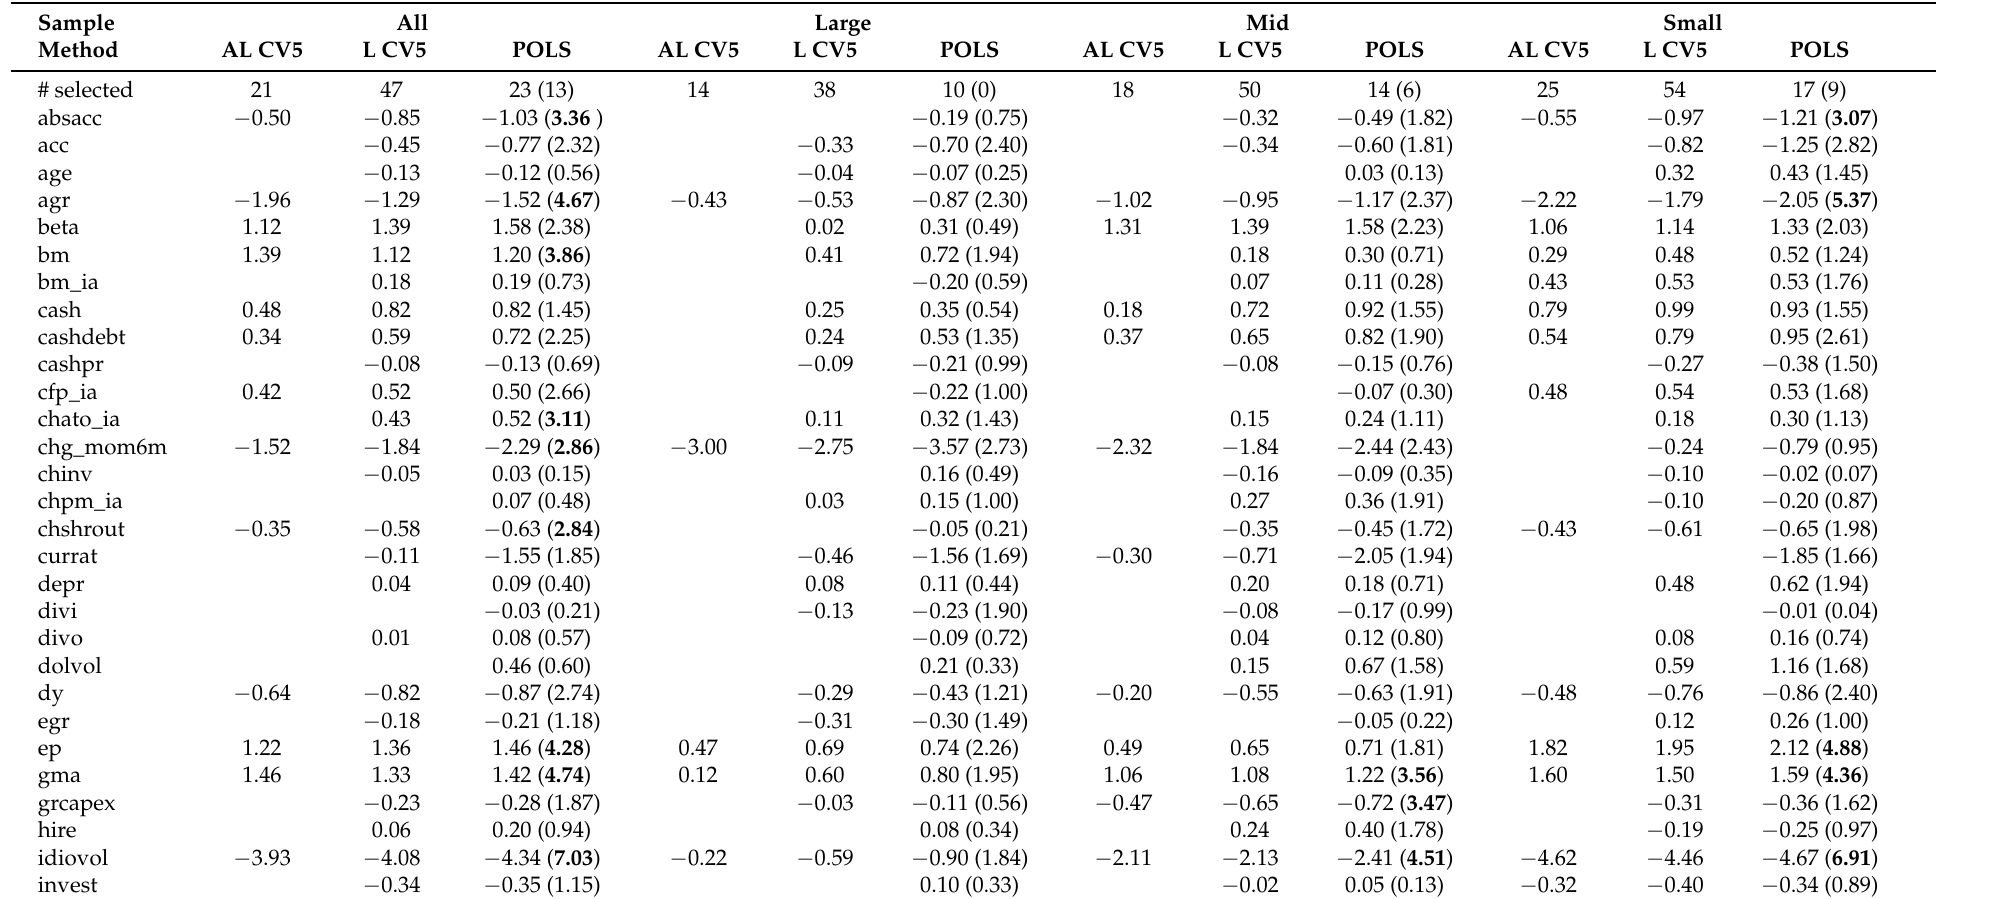
Table 3. Main pooled FC regression r = X (cid:48) γ + (cid:101) : The table exhibits the regression coefficients of POLS, Lasso (L) and adaptive Lasso (AL). POLS t-values are displayed in brackets, bold t-values indicate significance after a DFDR adjustment at the 5%-level. In case of POLS, row “# selected” counts FC with p -values ≤ 5%, the count for the DFDR equivalent is displayed in brackets. The other columns reflect the count of all non-zero FC coefficients. The estimation spans the period